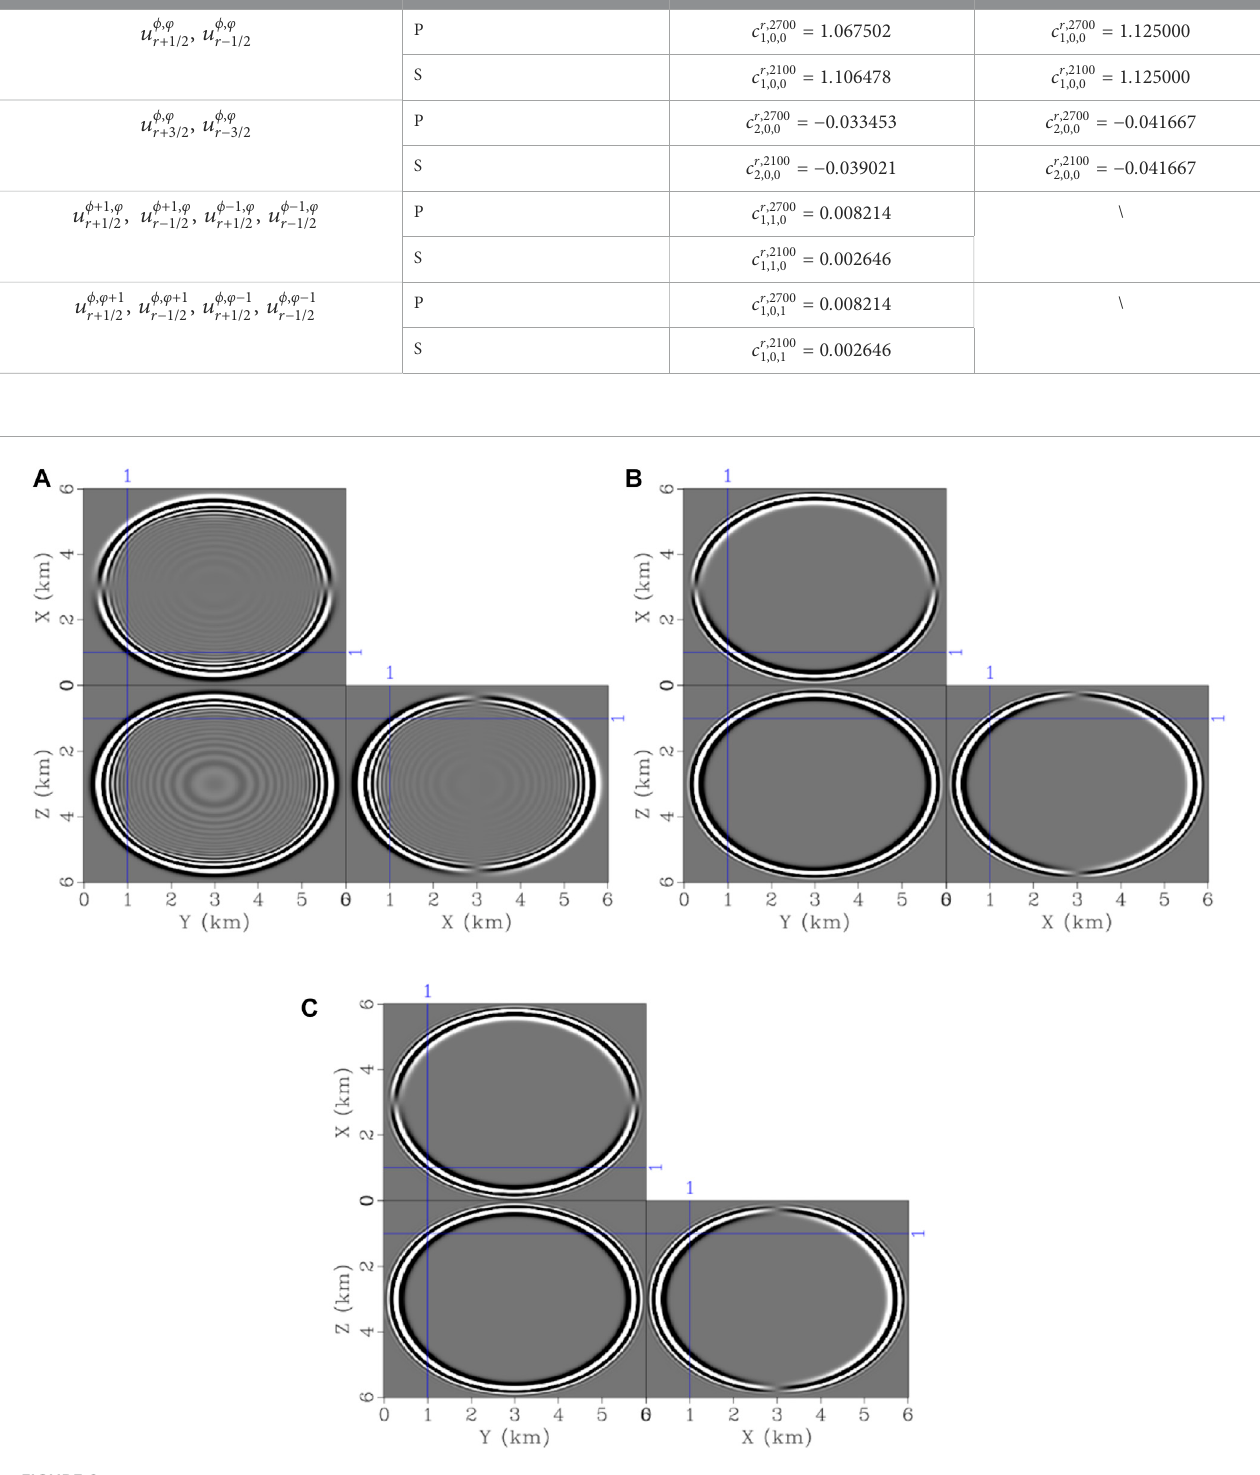
Frontiers in Earth